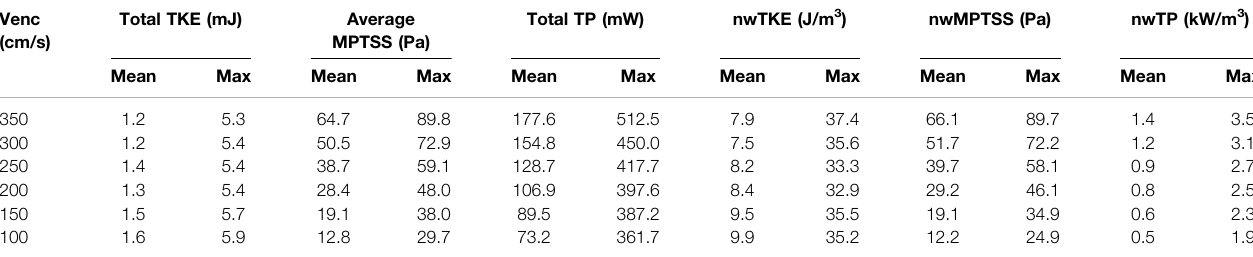
TABLE 2 | Summary of turbulence parameters from the in-vitro experiments. Venc (cm/s)